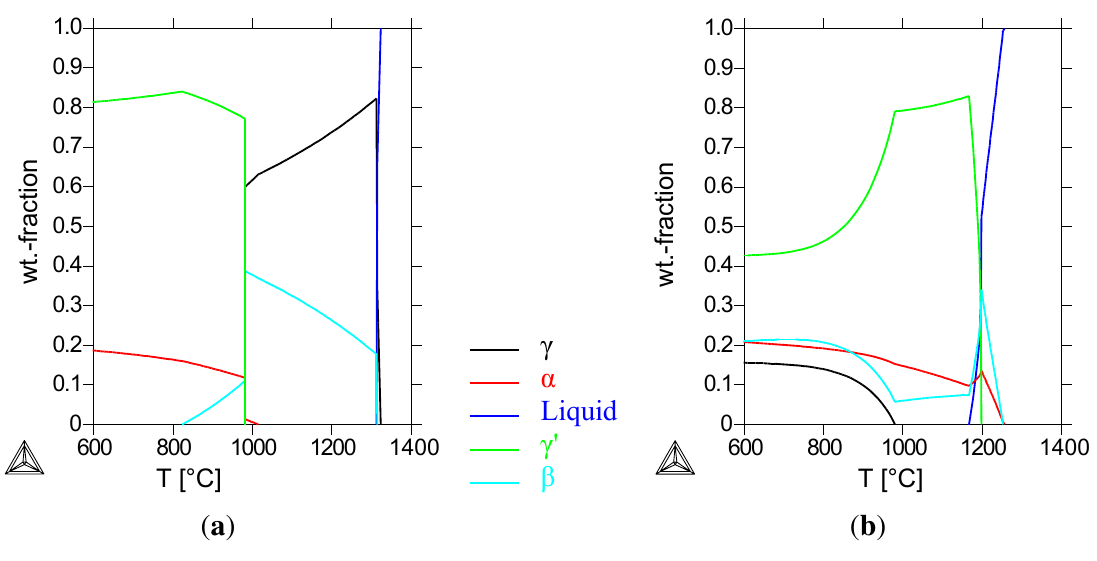
Figure 1. Calculated phase composition of the reference alloy Ni-22%Cr-10%Al and the reference alloy after adding 30% Cu (Ni-30%Cu-22%Cr-10%Al). ( a ) Ni-22%Cr-10%Al (a similar result was published in [15]); ( b )